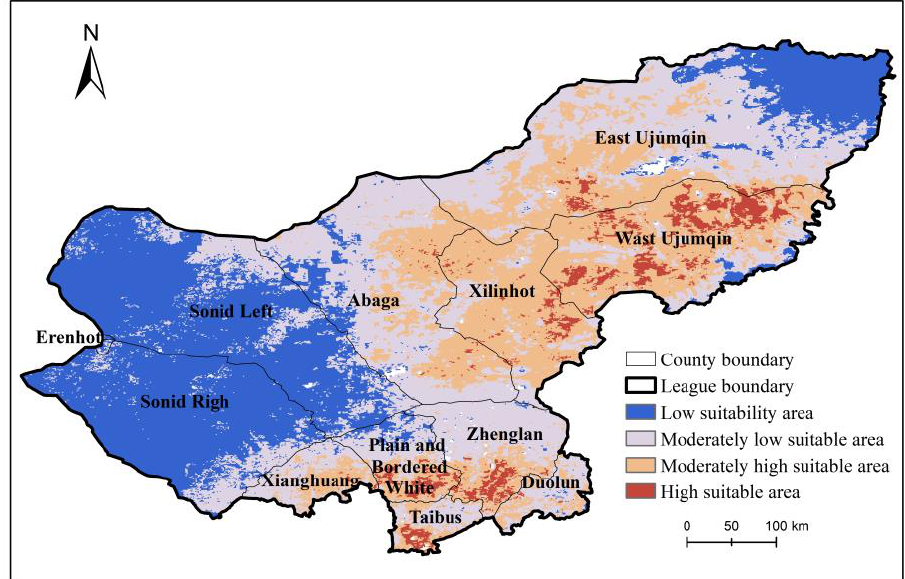
Figure 4. Modelling suitability of O. d. asiaticus occurrence by MaxEnt models. The suitability is classified into four levels: high suitability (>0.66, reddish-brown color), moderately high suitability (0.33 – 0.66, dark yellow color), moderately low suitability (0.05 – 0.33, grey color), and low suitability (<0.05, blue color).